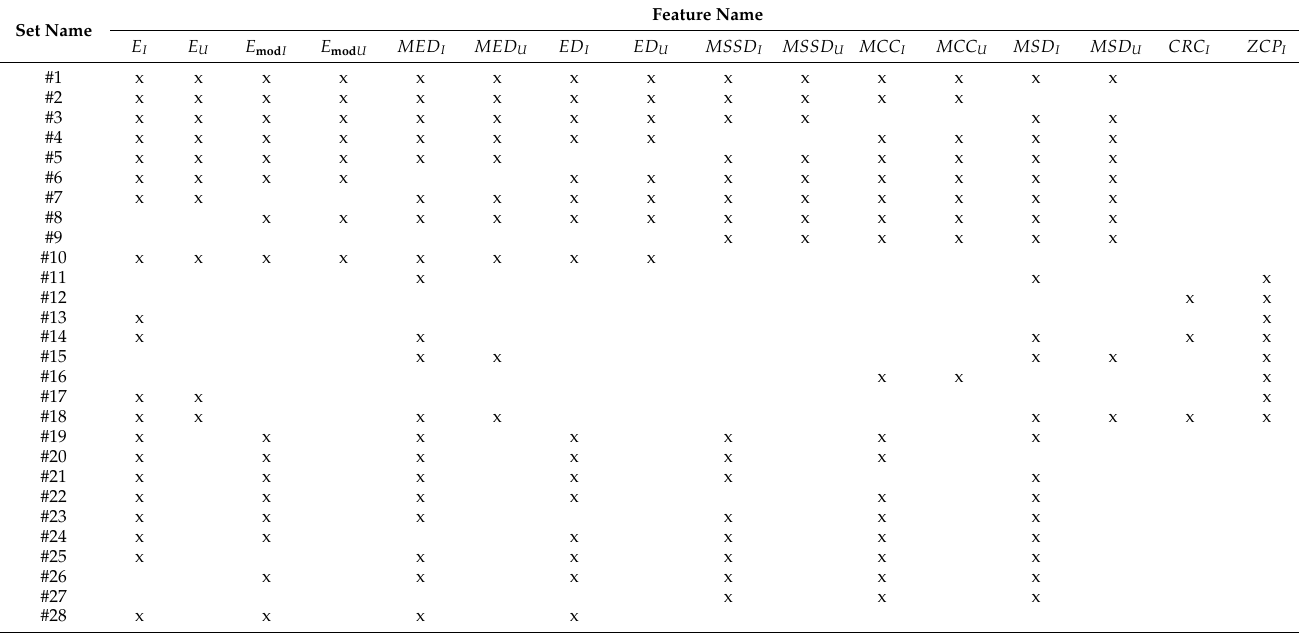
Table 3. Analyzed sets of